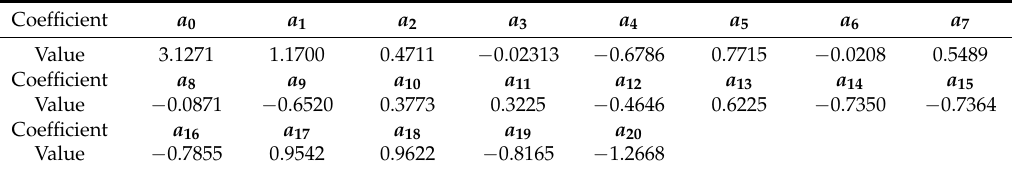
Table 6. Coefficients of Equation